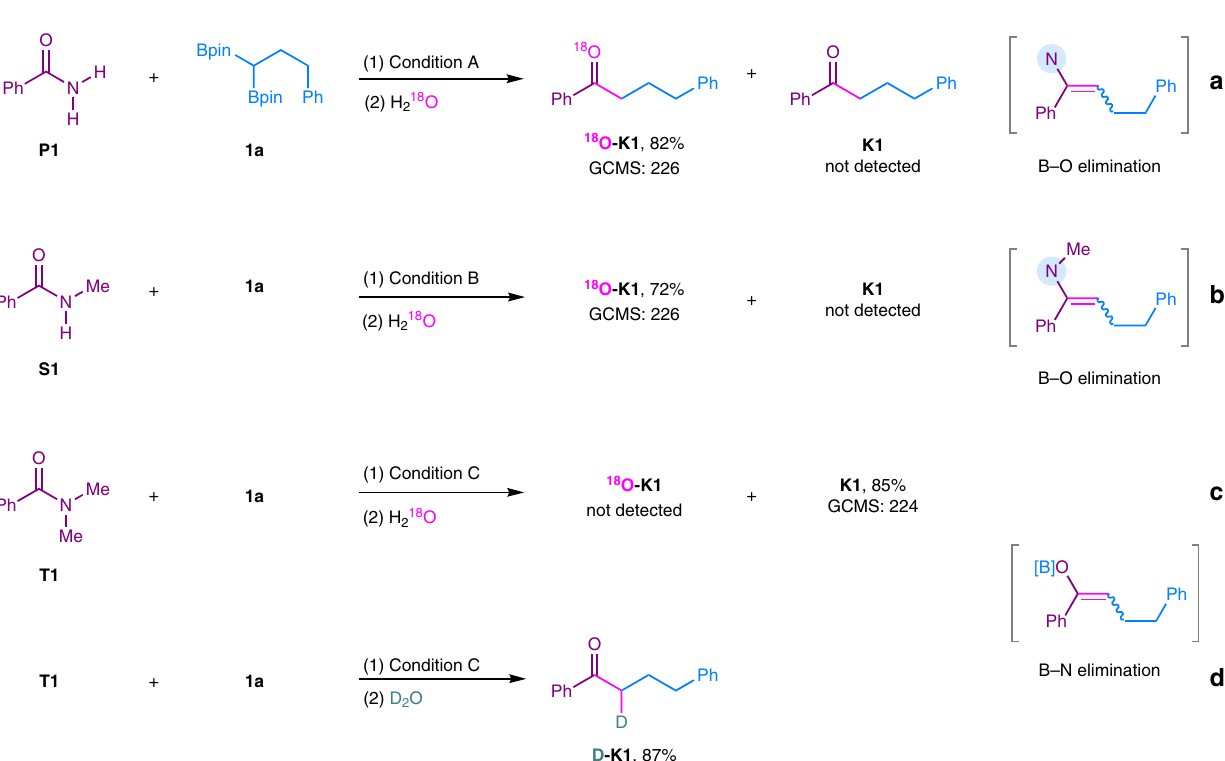
Fig. 3 Isotopic labeling experiments. a 18 O-labeling experiment of primary amide P1 . b 18 O-labeling experiment of secondary amide S1 . c 18 O-labeling experiment of tertiary amide T1 . d Deuterium-labeling experiment of tertiary amide T1